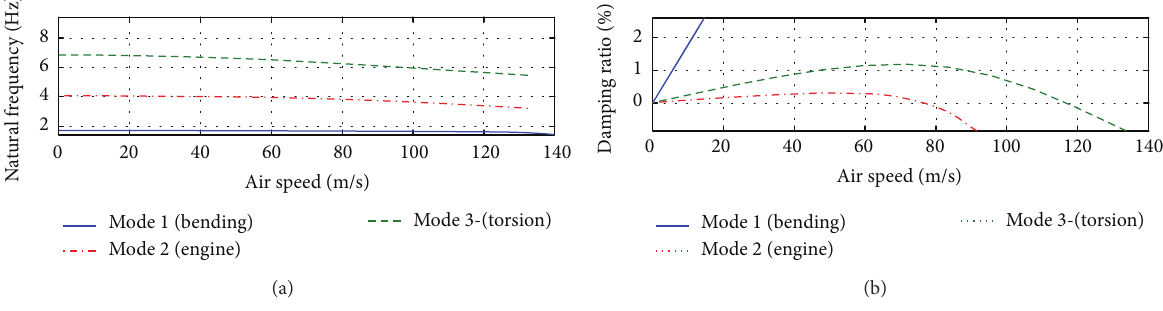
Figure 2: 𝑉 - 𝜔 and 𝑉 - 𝜁 plots for the wing-pylon-engine model.